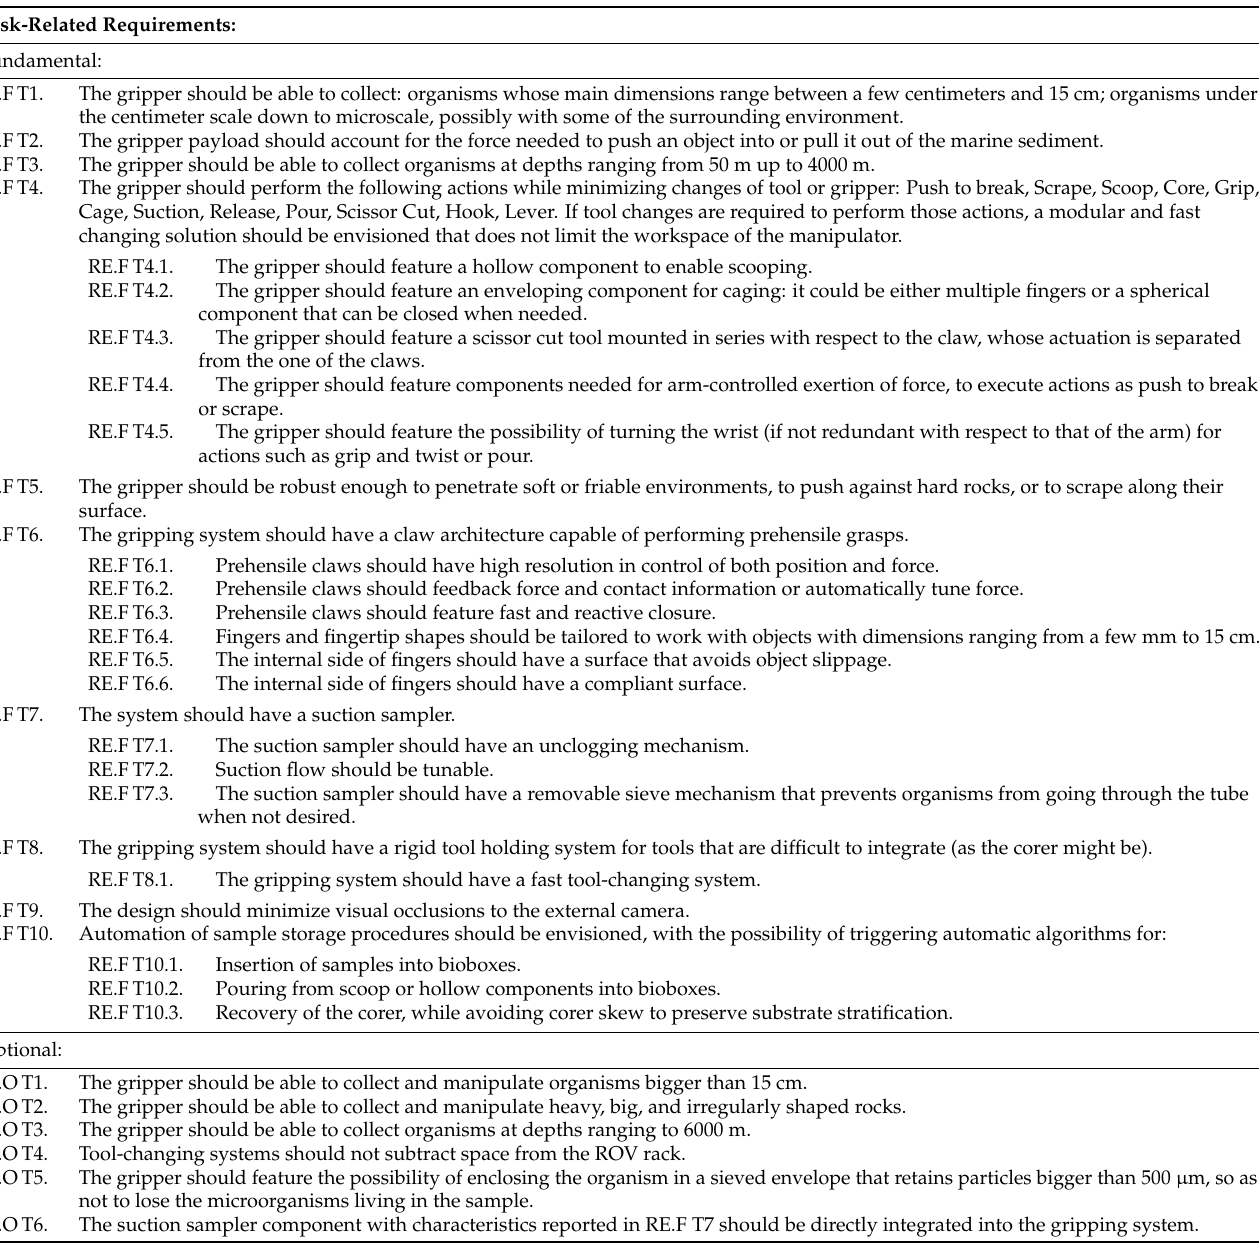
Table 7. Task-related